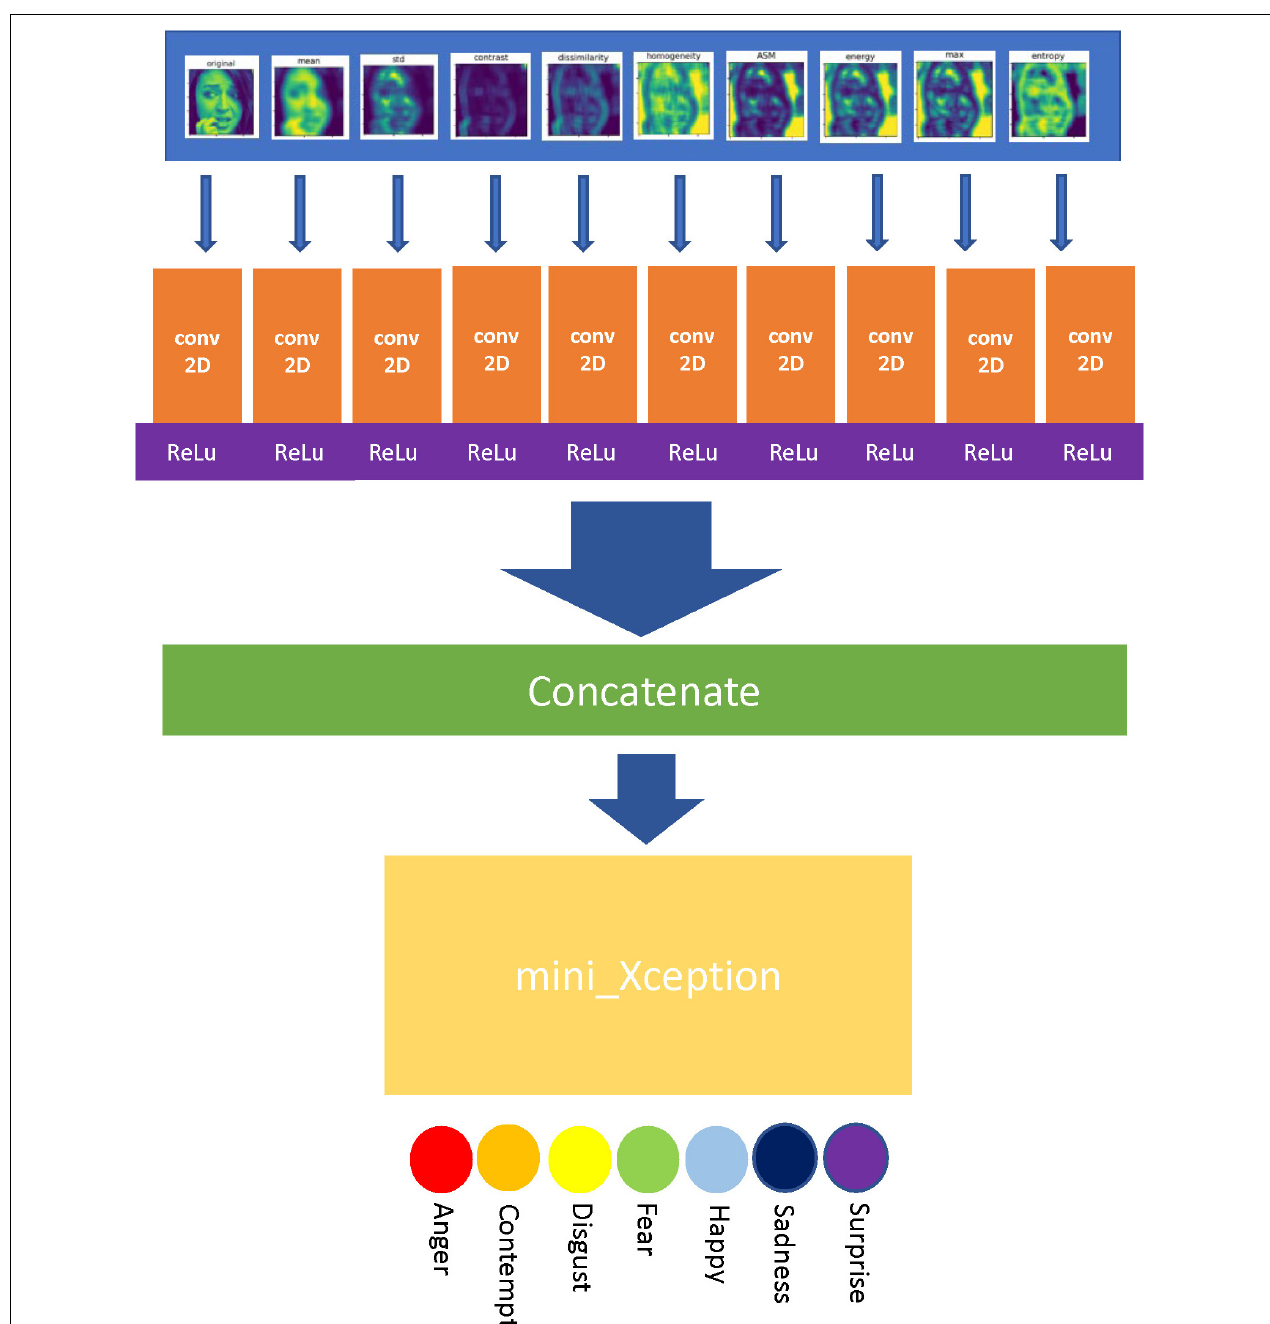
FIGURE 6 | Algorithm implementation flow